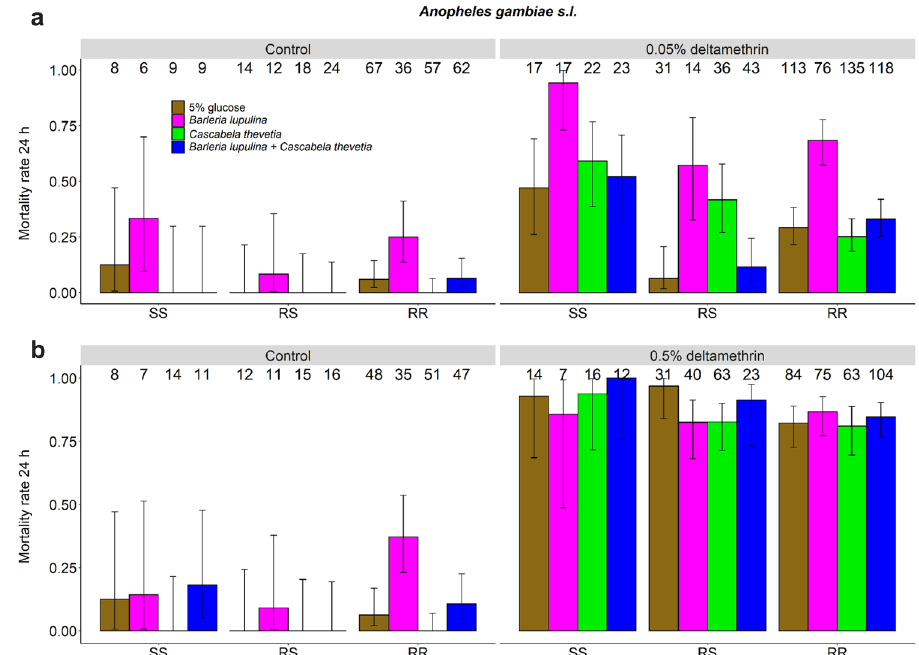
Figure 3. Effect of insecticide exposure, plant diet and kdr resistance genotype on the proportion of dead mosquitoes exposed to ( a ) 0.05% deltamethin, or ( b ) 0.5% deltamethrin over two replicates. The numbers above the barplots represent the sample size for each plant treatment. The letters on the x-axis correspond to the different kdr genotypes with SS designating homozygous susceptible mosquitoes, RS heterozygous mosquitoes and RR homozygous resistant mosquitoes. The error bars represent the variability of data with 95% confidence interval (± 95%